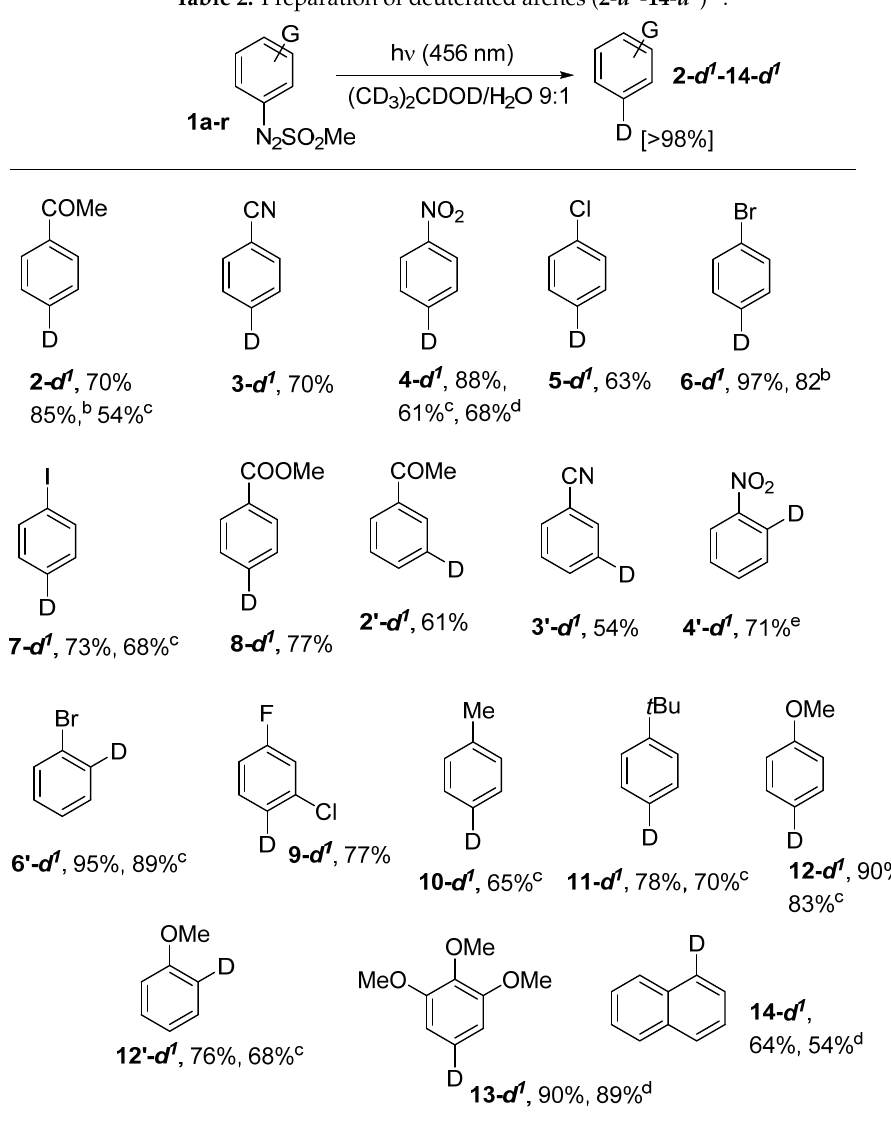
Table 2. Preparation of deuterated arenes ( 2- d 1 -14- d 1 ) a .